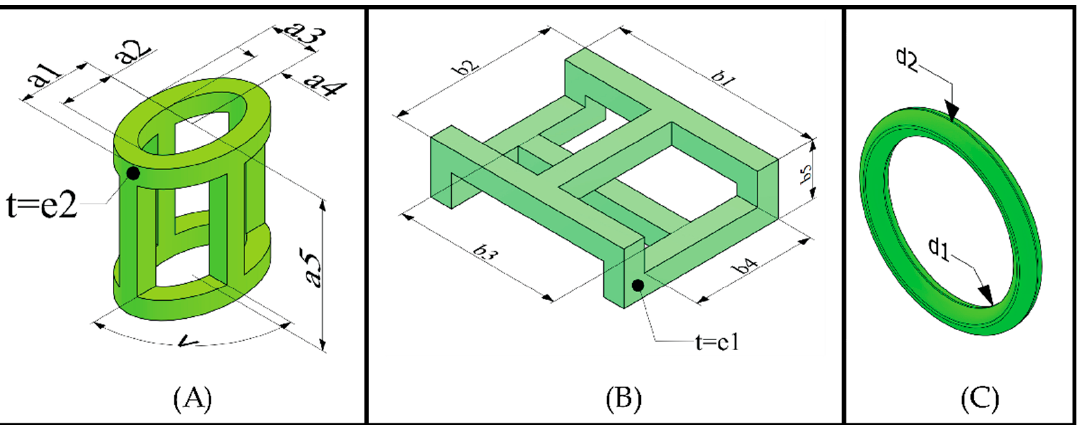
Figure 1. Designs of the elements that are composed of the different textile structures. ( A ) Cylindric element; ( B ) prismatic element; ( C ) annular element.